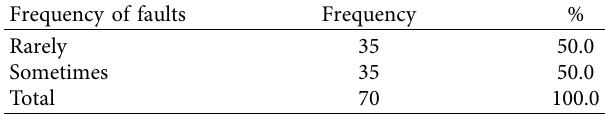
Table 21: Frequency of faults.